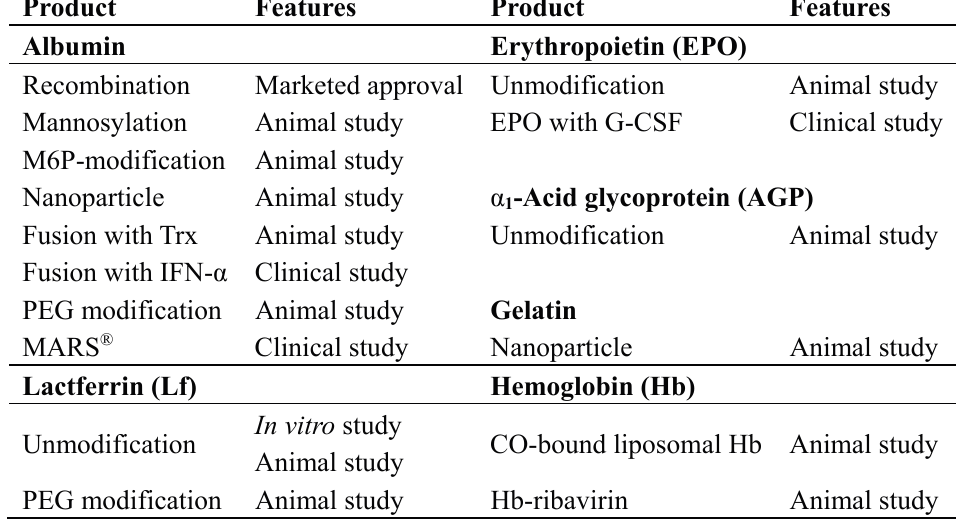
Table 1. Brief summary of biological and modified proteins for liver failure therapy that are in different stages of